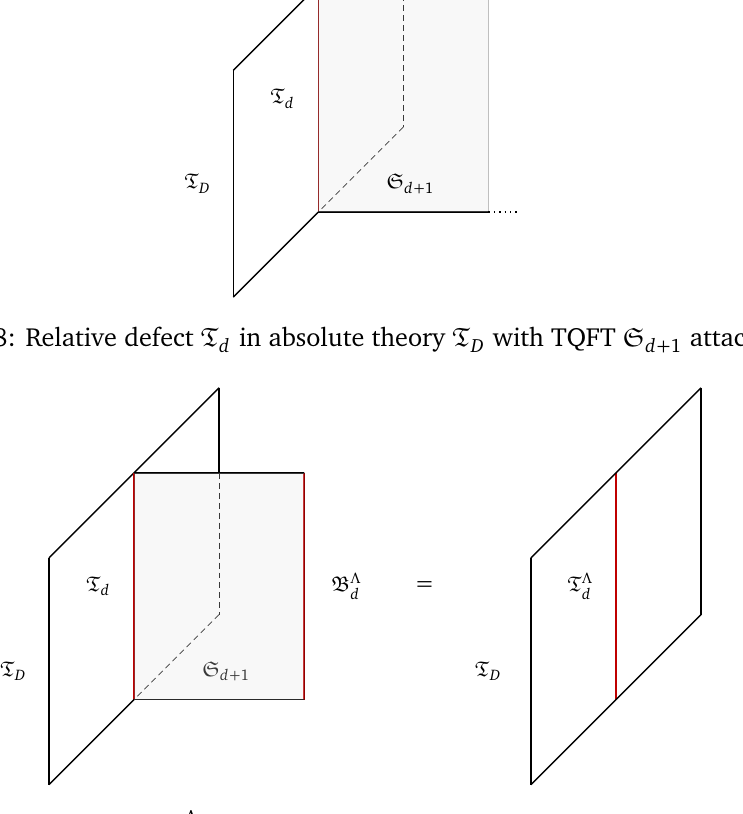
Figure 9: Absolute defect T Λ in absolute theory T d the relative defect T by choosing a topological boundary condition B Λ d TQFT S d + 1